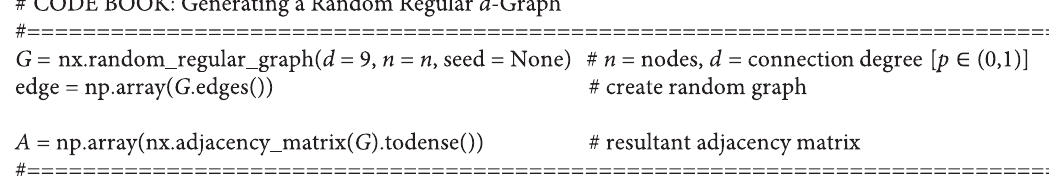
Figure 3: Code book: generating the graph and a random regular